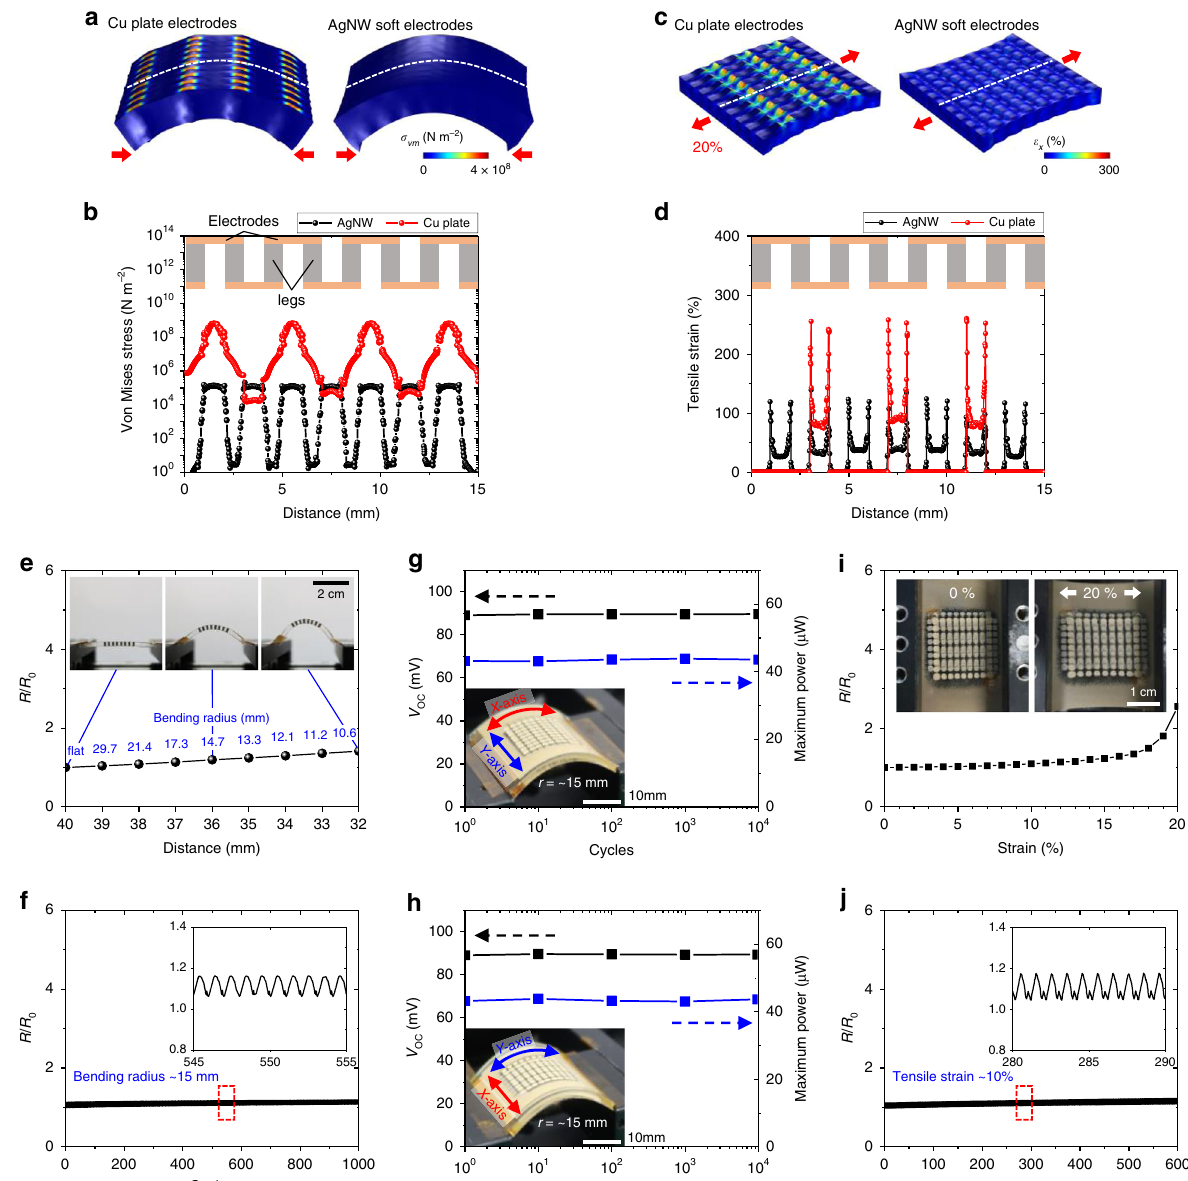
Fig. 4 Mechanical reliability of the compliant TEG. a FEA results showing the von Mises stress of the surfaces of a TEG with Cu plate electrodes and a TEG with AgNW-embedded soft electrodes under bending conditions. b Von Mises stress of the cross-sections indicated by the dotted lines in a . c FEA results showing the fi rst principal strain of the surfaces of the two TEGs under a uniaxial strain of 20%. d First principal strain of the cross-sections indicated by the dotted lines in c . e Resistance change as a function of distance between the ends of the TEG and its bending radius. The inset photographs show side views of the bent TEG for different bending radii. Scale bar, 2 cm. f Bending cyclic test of the compliant TEG showing stable electrical conductivity during and after bending cycles with bending radius ( r ) ~15 mm. The inset shows an enlarged view of the recorded data. g , h Experimentally measured TE performance of 36-np-pair-compliant TEG after different bending cycles with different bending directions of x -axis ( g ) and y -axis ( h ). The each inset is optical image of the bent TEG with the different bending directions of x -axis ( g ) and y -axis ( h ), respectively. Scale bars, 1 cm. i Resistance change as a function of uniaxial strain from 0 to 20%. The inset photographs show the compliant TEG under a strain of 0 and 20%. Scale bar, 1 cm. j Stretching cyclic test of the TEG showing stable electrical conductivity during and after stretching cycles with a strain of